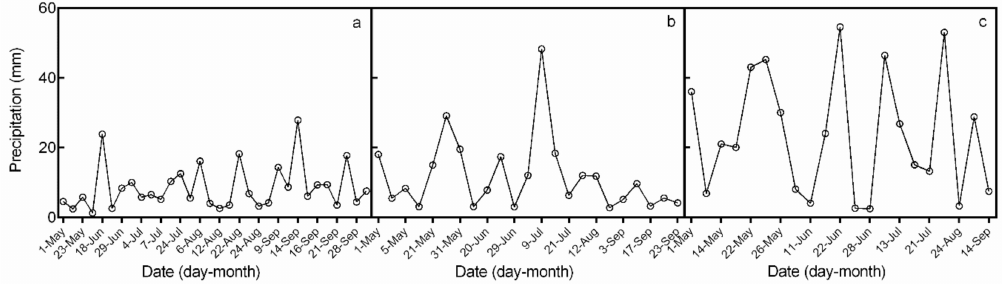
Figure 1. Daily precipitation during the 2014 ( a ), 2015 ( b ), and 2016 ( c ) growing seasons.